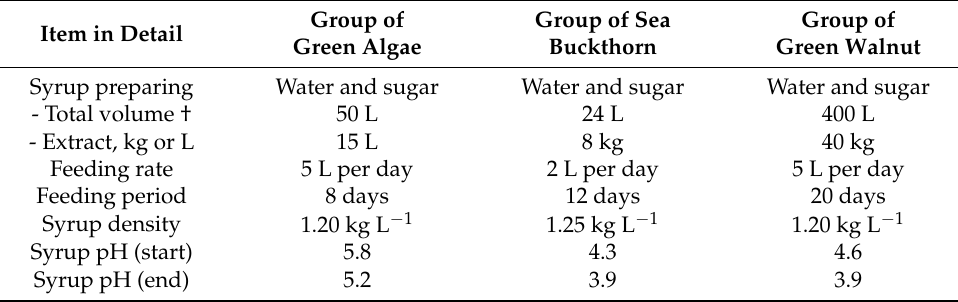
Table 2. Basic information about the preparation of syrup for honey production in each